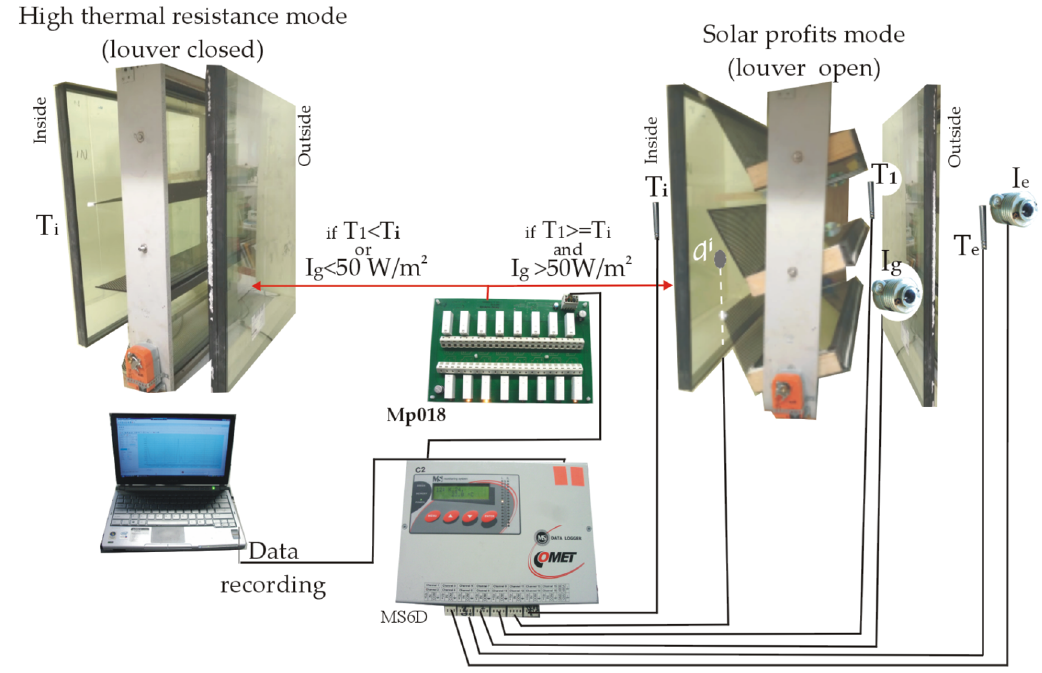
Figure 6. Measuring and control system diagram.